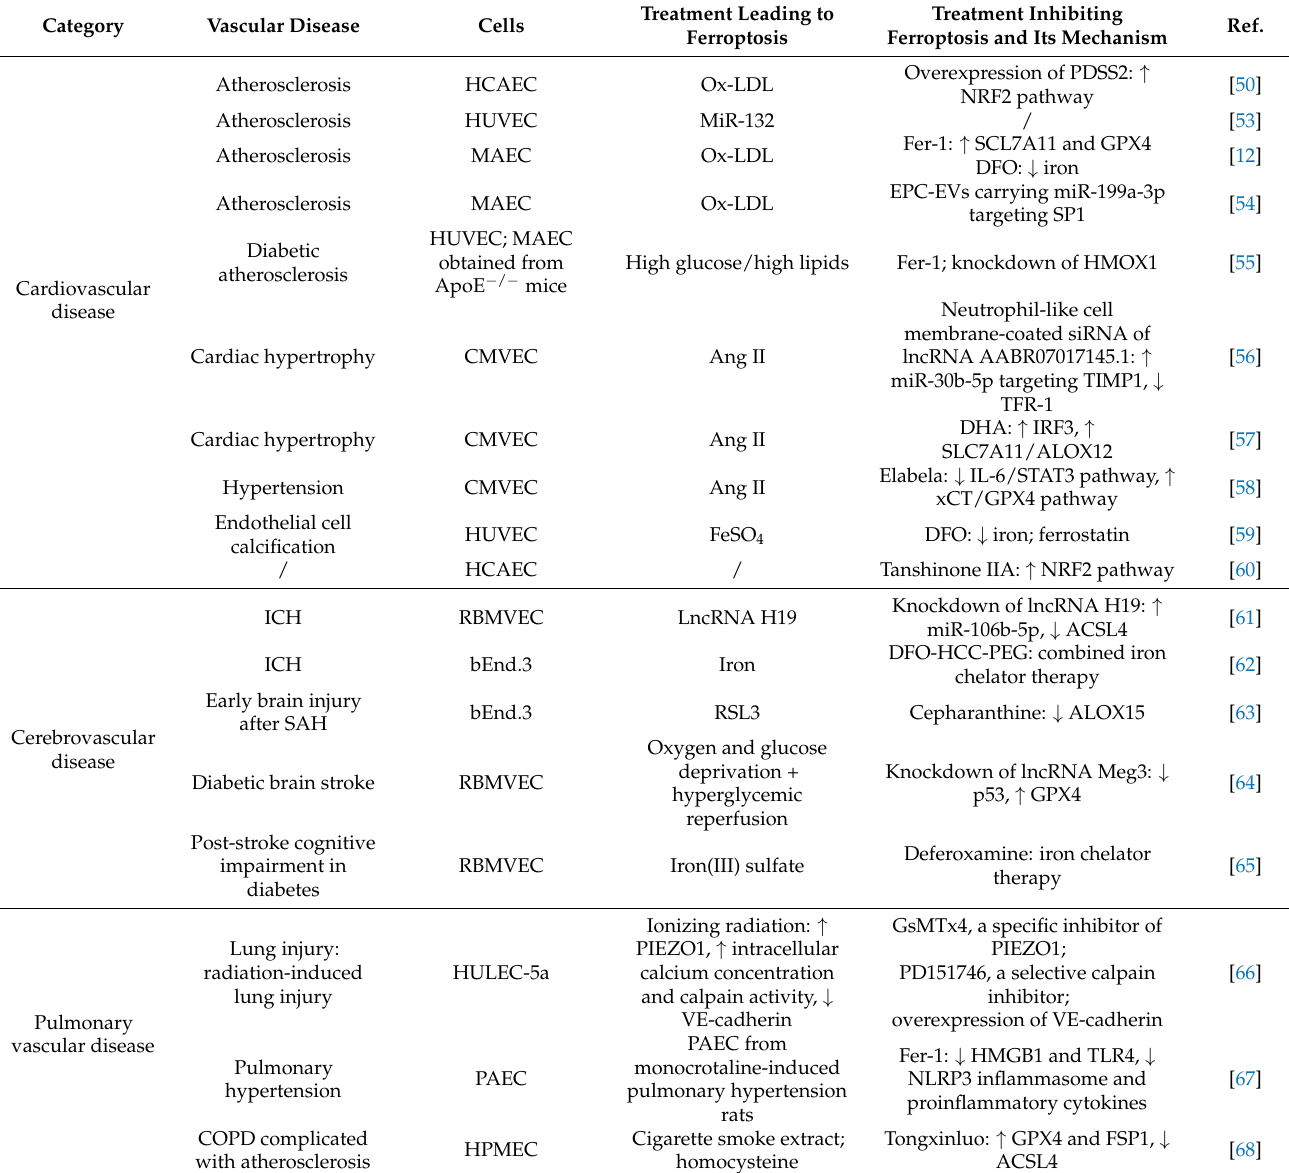
Table 2. Treatment associated with ferroptosis of ECs in vascular diseases.